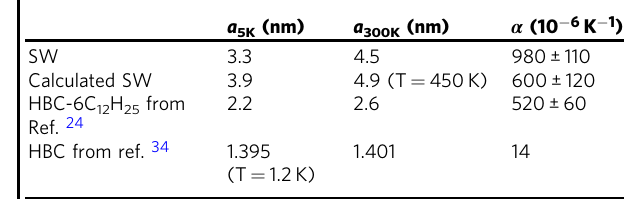
Table 1 Thermal expansion coef fi cients α of interdigitated 2D molecular